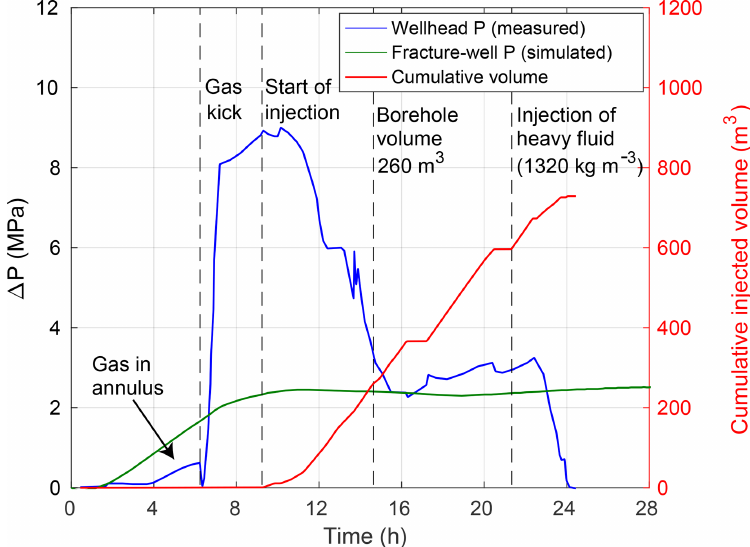
Figure 8. Measured wellhead pressure, simulated bottom hole pressure (fracture zone/well intersection inside fracture zone), and cumulative injected volume with time during the gas kick and well control injection. The vertical dashed black lines mark important events during the well operation (see text for more detailed explanations). The simulated overpressure at the bottom hole does not exceed the wellhead pressure prior to the injection of heavy fluids. Zero-time corresponds to the breach of the seal to initiate the gas kick in the simulation. Note that the injection is not modeled